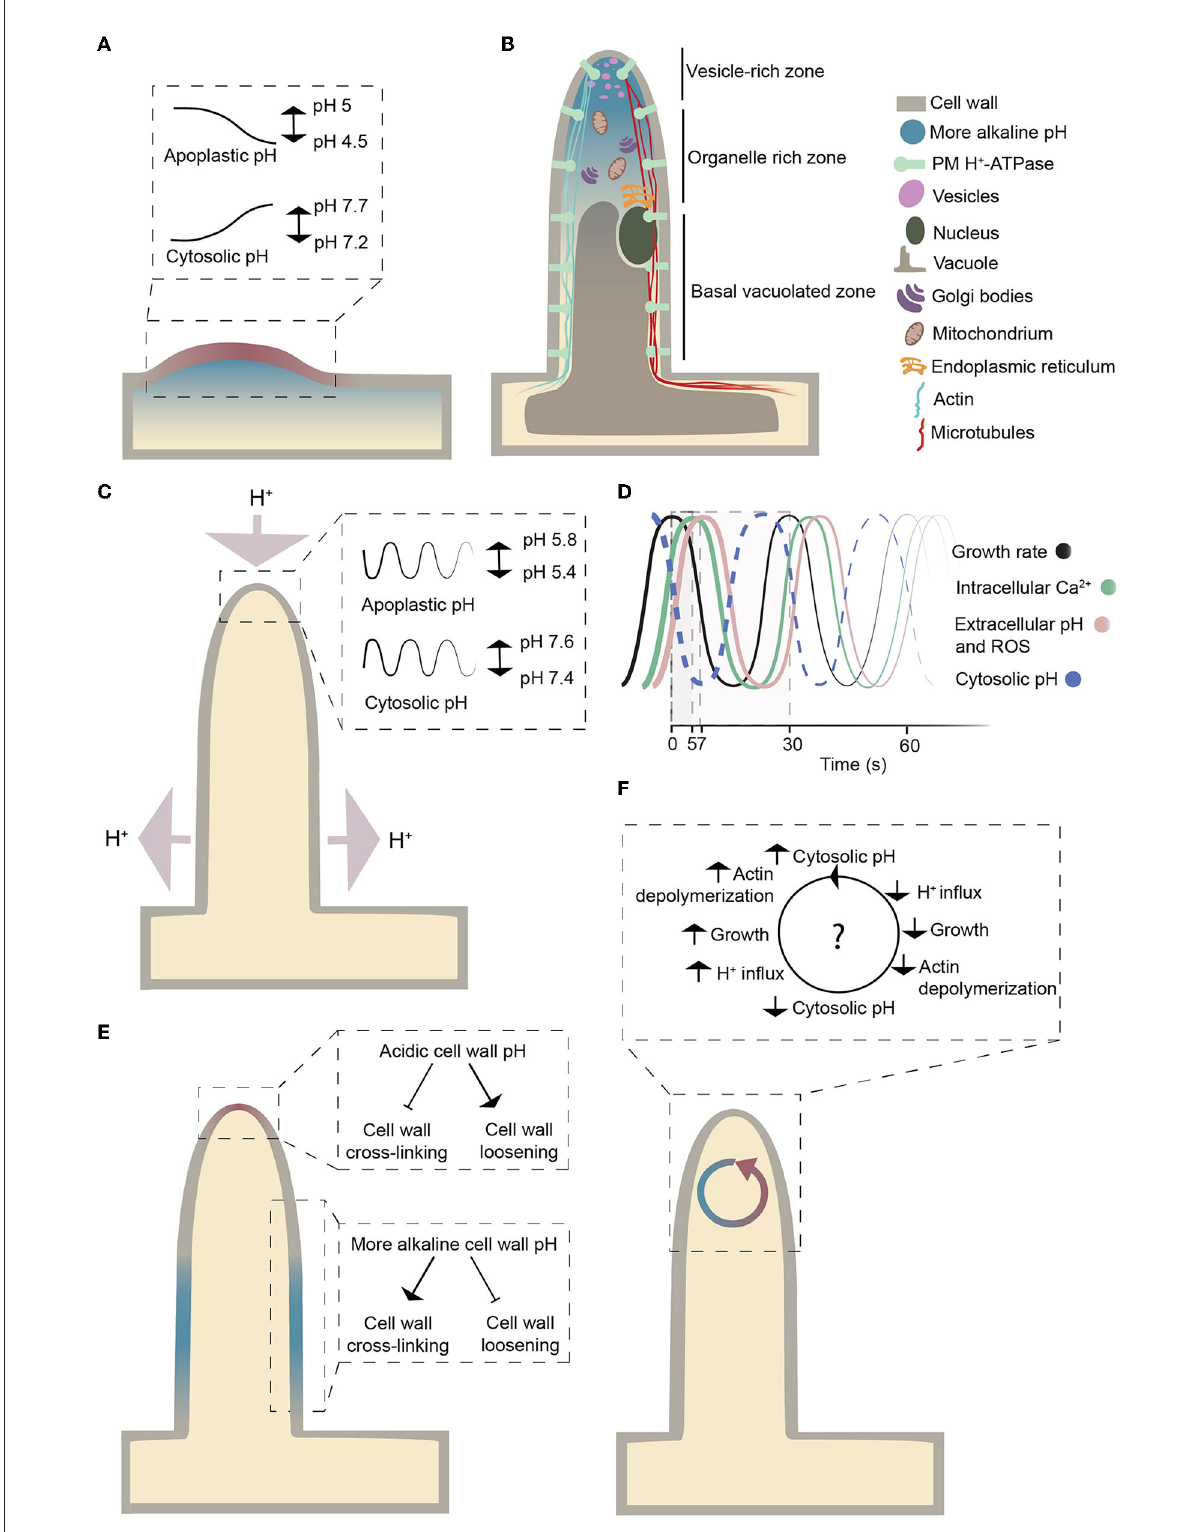
FIGURE1 Schematic representation of a growing root hair. (A) The pH changes during bulge formation in Arabidopsis. The pH values are based on data in Bibikova et al. (1998). Colors indicate a localized pH increase (blue) and decrease (red) at the site of initiation in trichoblasts. (B) Schematic representation of the cytosolic pH gradient and the organelles within a growing root hair. The figure is adapted from Datta et al. (2011). A more